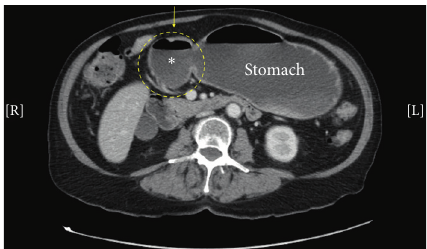
Figure 1: Initial abdomen computed tomography scan showing nonspecific fluid distension of the stomach with possible diverticulum (circle).